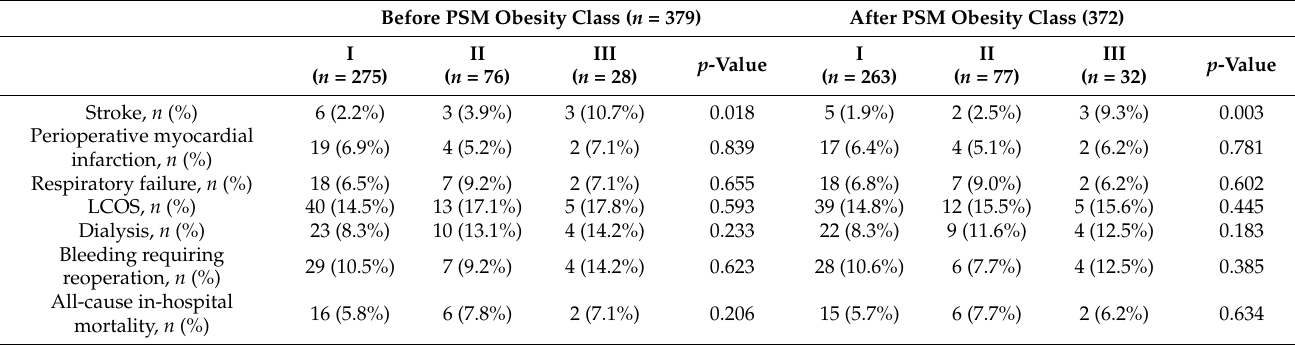
Table 4. Primary and secondary outcomes by obesity classes (I, II,